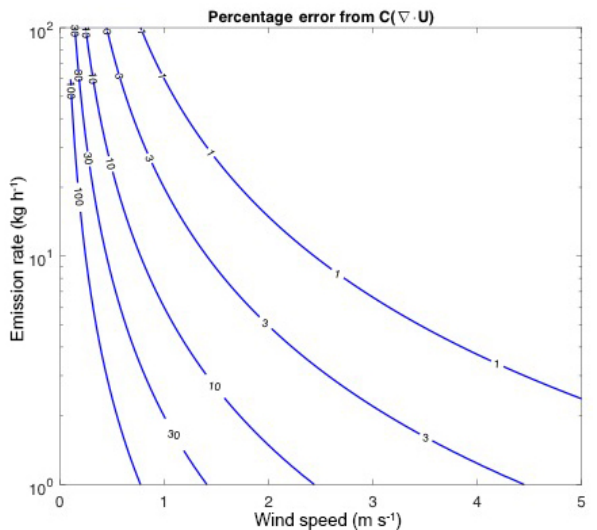
Figure 2. Graphical representation of the relative magnitude (%) of the contribution of the horizontal wind divergence to the hori- zontal advective terms in Eq. (3), as a function of wind speed and source magnitude for methane, using a typical global background of 1.9ppm and divergence of 10 − 5 s − 1 .